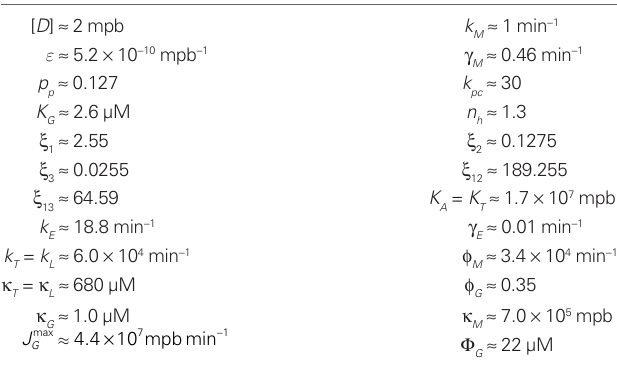
Table 2 | Parameter values for the lac operon model. These parameters were taken from Santillán (2008), except for K estimated in this work. Here, mpb stands for “molecules per average-size